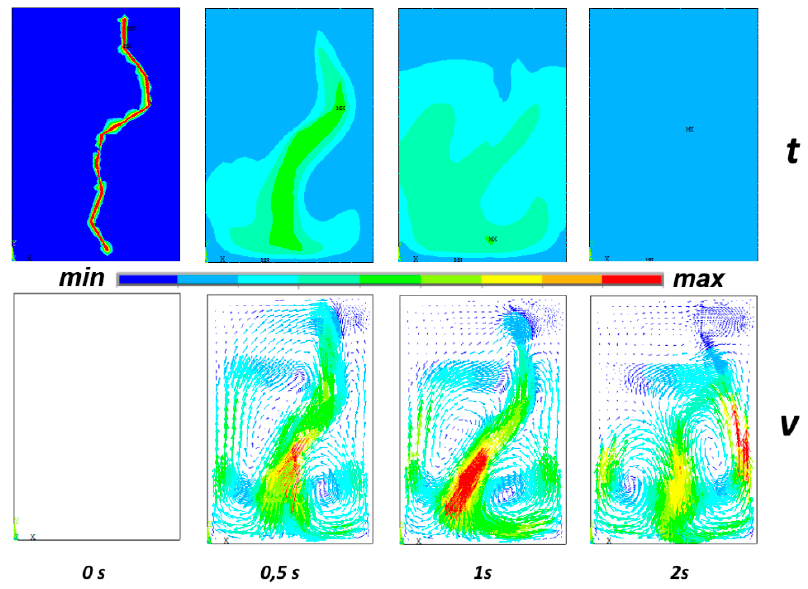
Figure 19. Temperature distribution ( t ) and fluid velocity vectors ( v ) in analyzed sample in different time steps.